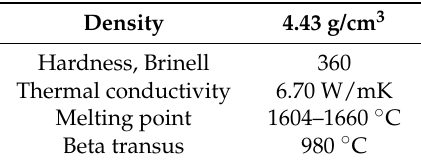
Table 1. Proprieties of the Ti6Al4V